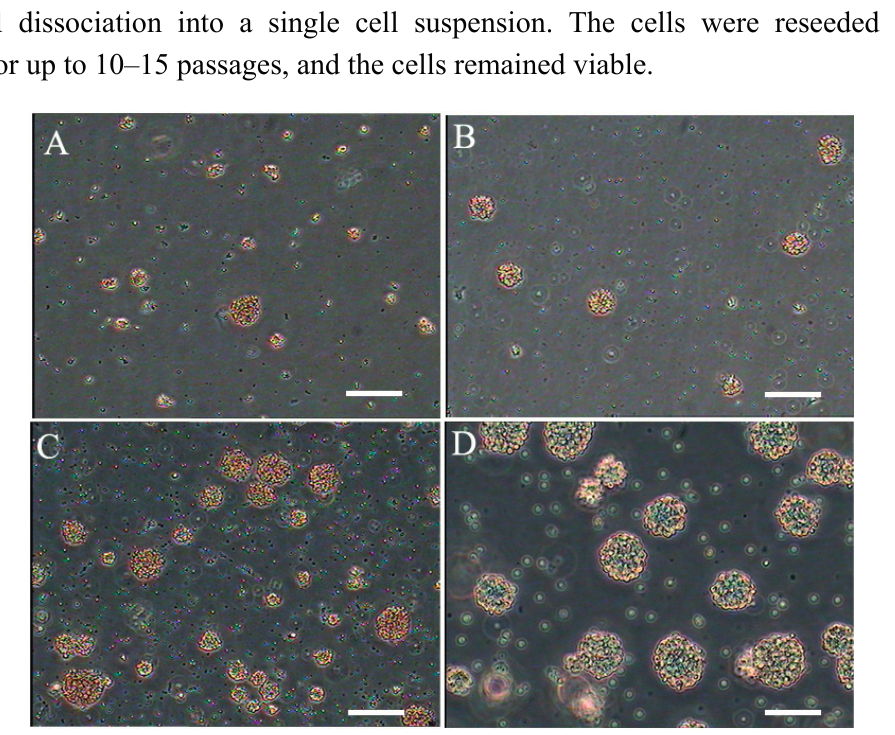
Figure 1. Floating neural spheres generated from bovine brain in different medium. ( A ) medium I; ( B ) medium II; ( C ) NSCs cultured in medium III 7 days and ( D ) cultured in medium III 20 days. Scale bar = 200 μ